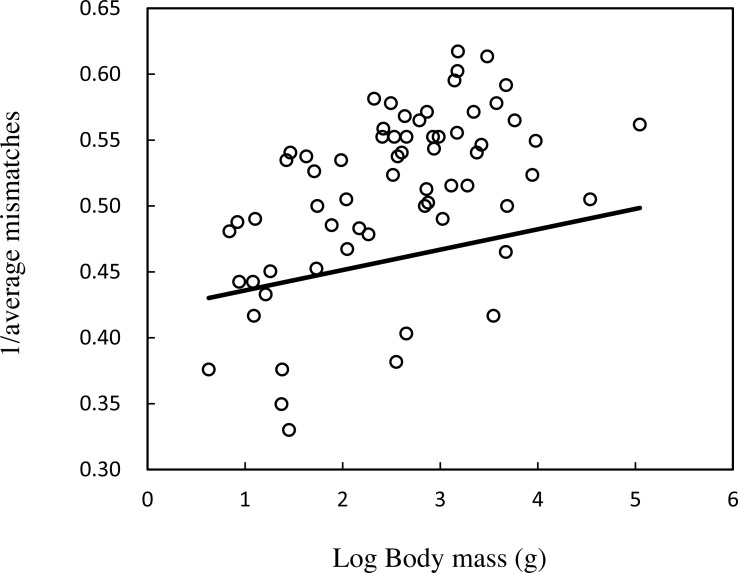
Regression scatterplot of the inverse of the average mismatches of imperfect SSRs on the log of body mass in whole genome scale.